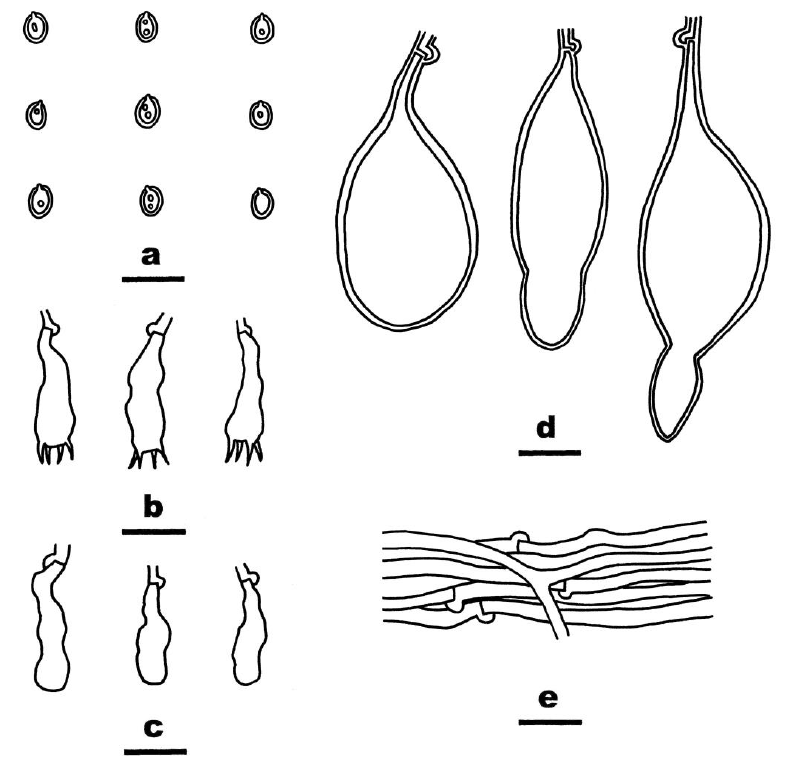
Figure 6. Cystostereum crassisporum (from the holotype BJFC 024259). Scale bars: ( a – e ) = 10 µm. ( a ). Basidiospores; ( b ). Basidia; ( c ). Basidioles; ( d ). Gloeocystidia; ( e ). Generative hyphae from subiculum.